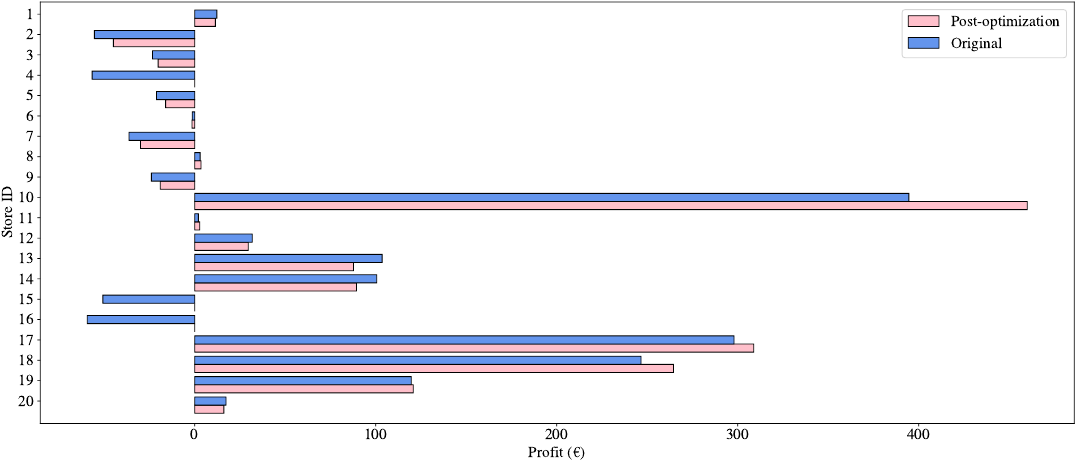
Figure 5. Distribution of sales profit in the